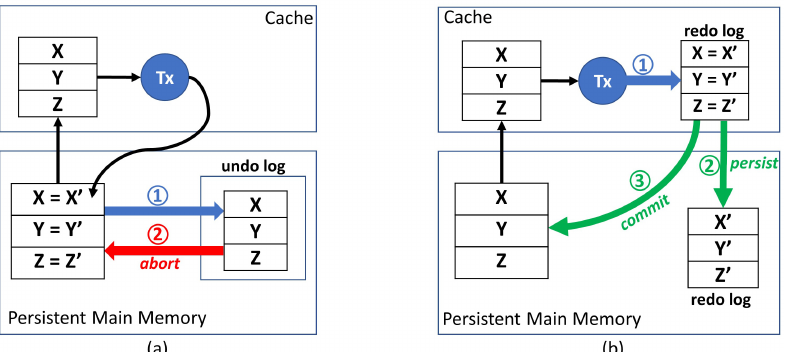
Figure 1. An illustration of how a transaction T x is executed in persistent memory using ( a ) eager versioning and ( b ) lazy versioning. Figure ( a ) depicts two kinds of operations in eager versioning. The first operation is to copy the data from original memory locations to a log area (called undo log) in the persistent main memory and the second is to copy the data back from the log area to the original memory locations, in case T x aborts. If T x commits, the data in the log area is simply discarded. Figure ( b ) depicts three kinds of operations in lazy versioning. The first operation is to copy the data from original memory locations to a log area (called redo log). Transaction T x updates on this redo log. The second operation is to persist the redo log in persistent memory and the third operation is to copy the updated data back from redo log to the original memory locations. The second and third operations are required only in case T x commits. If T x aborts, the data in the redo log area in cache is simply